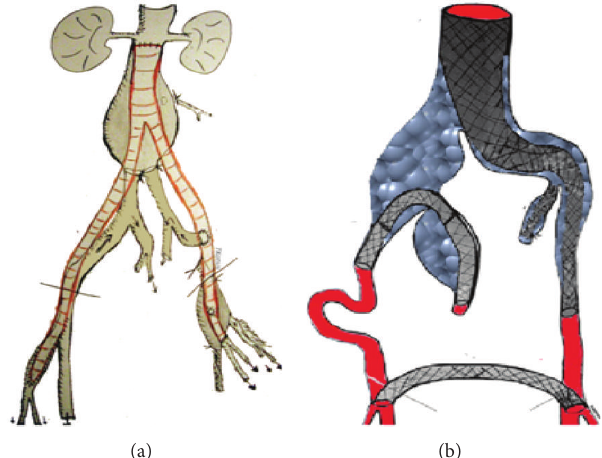
Figure 8: Two cases of complex open (a) and combined (b) reconstructions,